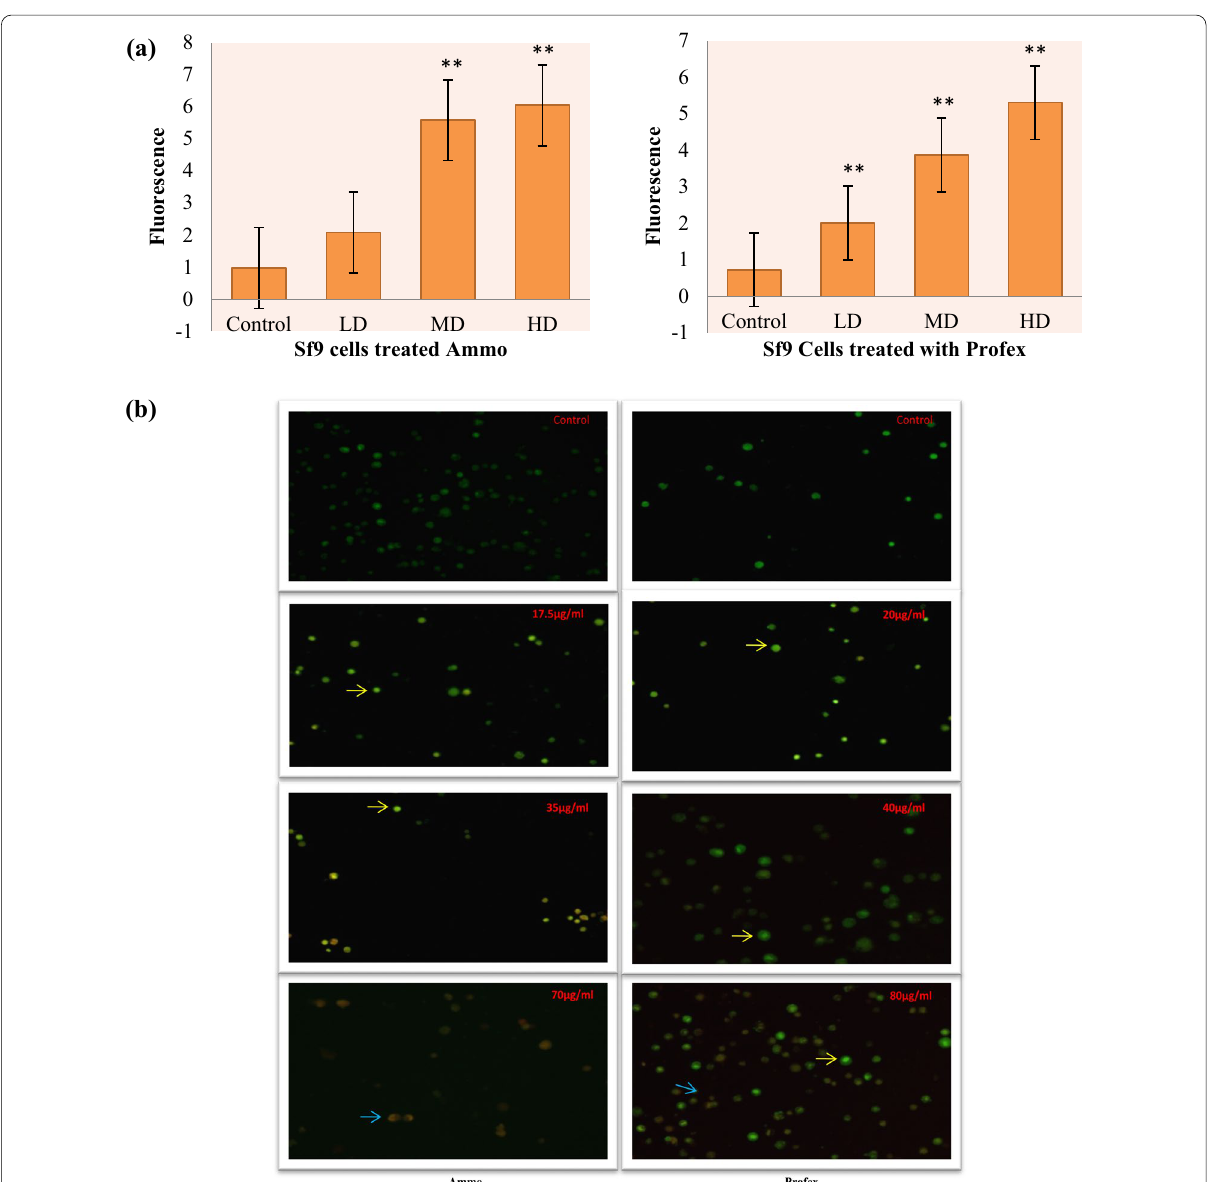
Fig. 3 Results of acridine orange/ethidium bromide assay for Sf9 cells after treatment with sub-lethal concentrations (Low Dose, Medium Dose and High Dose) of Ammo and Profex. a Depicts the fluorescence (mean SE) in Sf9 cells after treatment with sub-lethal doses of Ammo and ± Profex for 48 h and stained with AO/EB. ( p < 0.5*, p < 0.05**). b Show Sf9 cell treated with Ammo in an increasing concentrations of LD MD 35 μg/ml and HD 70 μg/ml and Profex with LD 20 μg/ml, MD 40 μg/ml and HD 80 μg/ml in comparison to Control. Here, the yellow = = = = = arrow indicates early apoptotic cells and the blue arrow indicates Late apoptotic